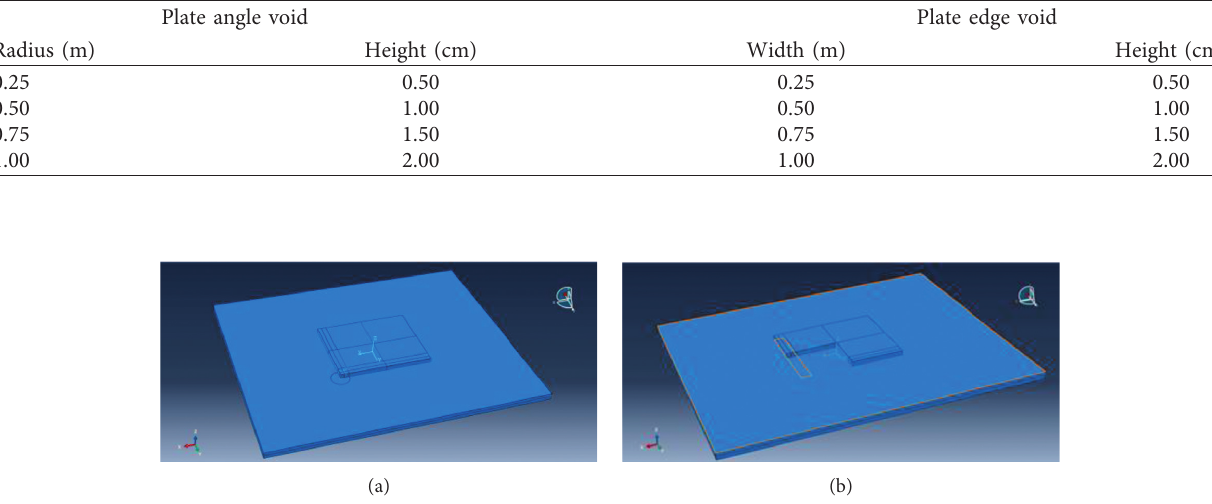
Figure 1: Schematic of plate angle and edge voids of the cement pavement. (a) Plate angle void of cement pavement. (b) Plate edge void of cement pavement.